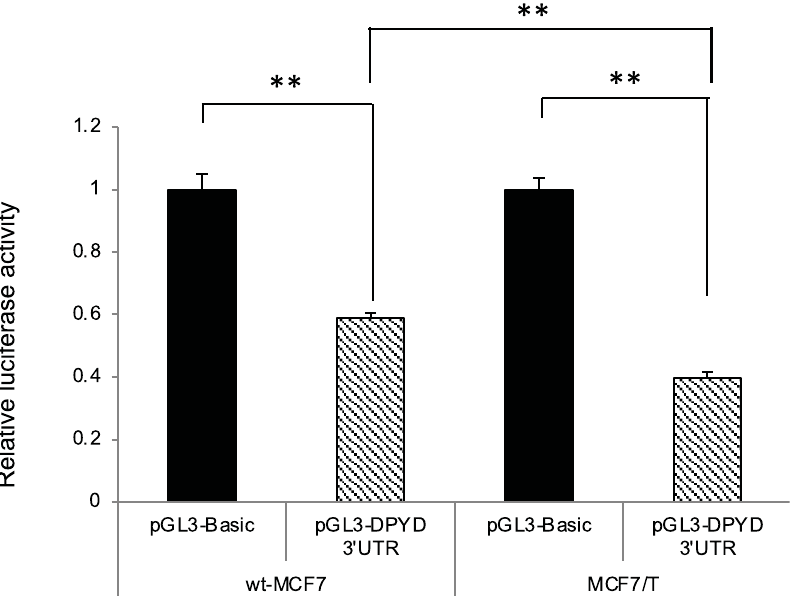
Fig 7. DPYD 3 0 -UTR activity in wild-type MCF7 and tamoxifen-resistant MCF7 cells. Wild-type (wt)-MCF7 and TAM-resistant MCF7 (MCF7/T) cells were transfected with the pGL3-DPYD3 0 UTR, and luciferase activity was measured as described in the Materials and Methods. The data shown were normalized with the internal control. The error bars represent the standard deviations of the values obtained in the experiments performed in triplicate. The experiments were repeated independently at least three times, and one representative result is provided in the figures. NS, not significant; �� p < 0.01 by one-way ANOVA with Tukey’s multiple